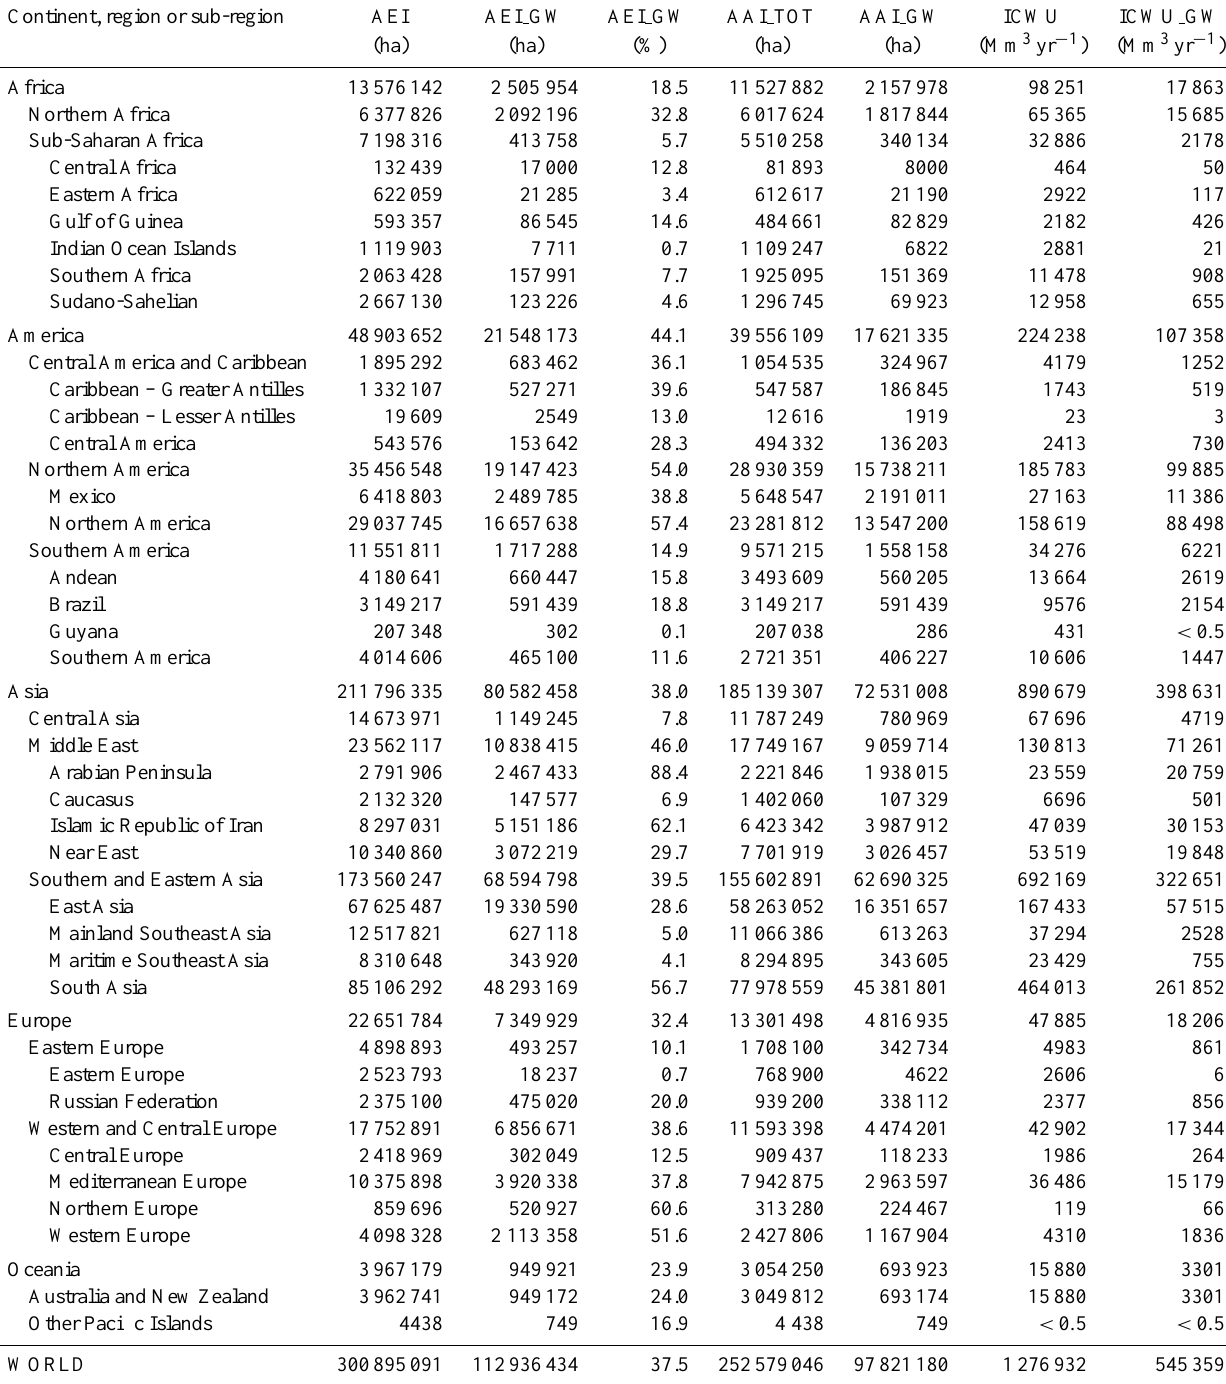
Table 2. Total area equipped for irrigation (AEI), area equipped for irrigation irrigated with groundwater (AEI GW), total area actually irrigated (AAI TOT), area actually irrigated with groundwater (AAI GW), total consumptive irrigation water use (ICWU) and consumptive groundwater use for irrigation (ICWU GW) per continent, region and